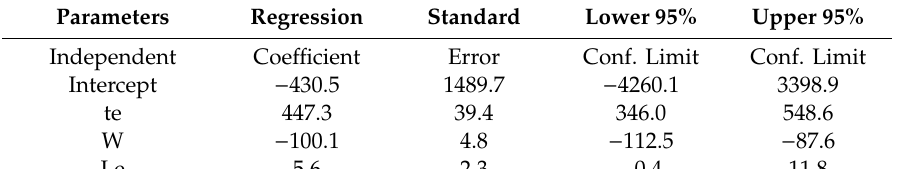
Table 4. Regression coe ffi cients confidence intervals.